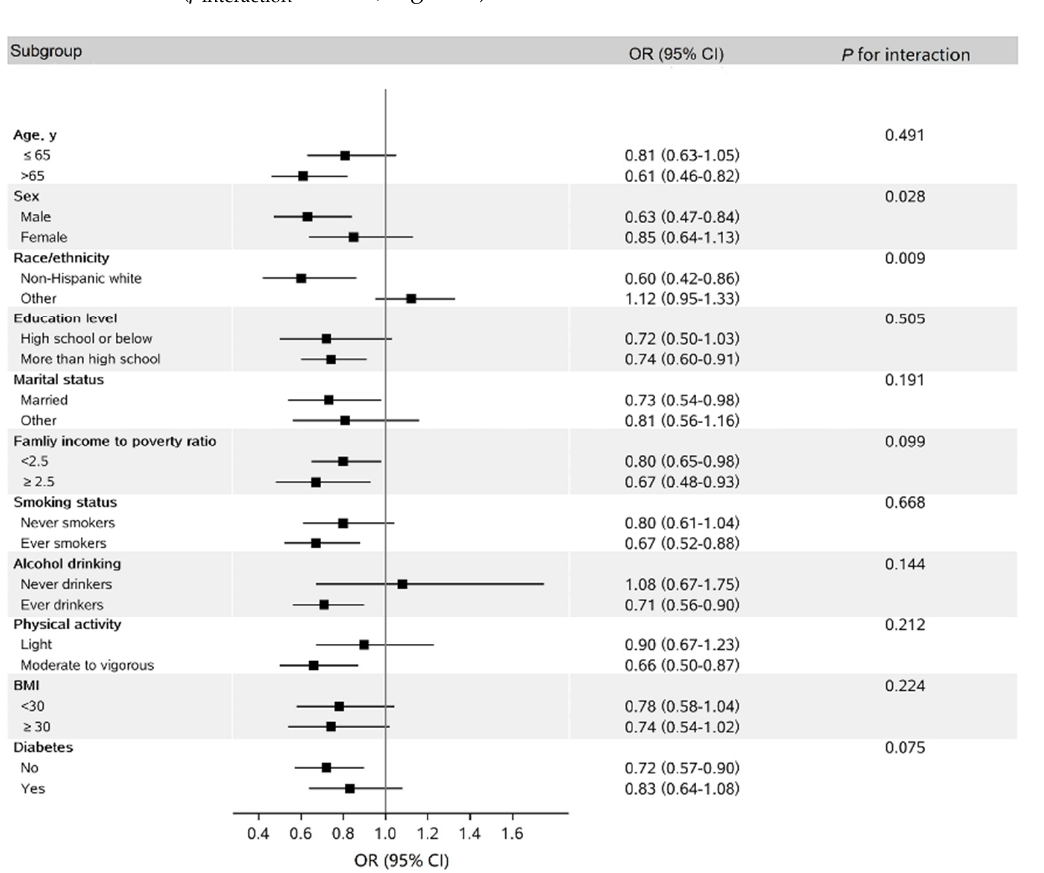
Figure 2. Subgroup analysis for the association between hPDI scores (per 10–point increase) and odds of NAFLD a . BMI, body mass index; CI, confidence interval; hPDI, healthful plant-based diet index; METS, metabolic equivalent tasks; NAFLD, nonalcoholic fatty liver disease; OR, odds ratio. a The models were adjusted for the same covariates as those listed for model 3 in Table 2 except for the variables examined in this figure. Physical activity <8.3 METS–h/week was defined as light phys- ical activity, and ≥ 8.3 METS–h/week was defined as moderate to vigorous activity. Participants with any missing values in covariates were excluded from the subgroup analysis.